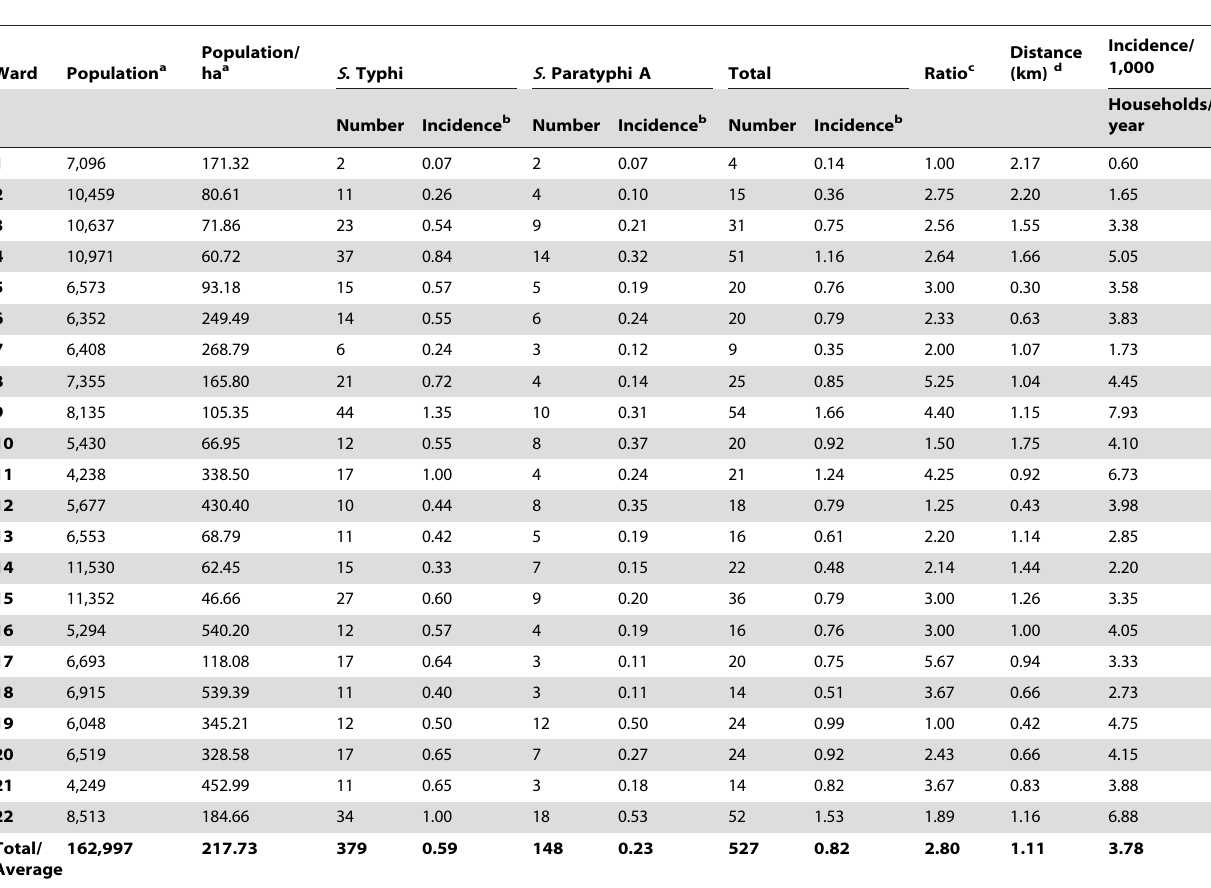
Table 1. The average annual incidence of enteric fever cases in LSMC, by ward of residence.